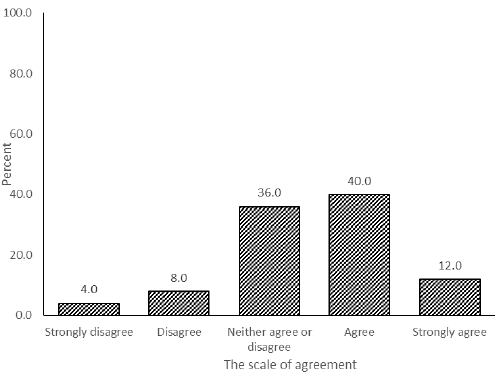
Figure 3. The implementation of the species strategic management plan and research procedures by the institution.